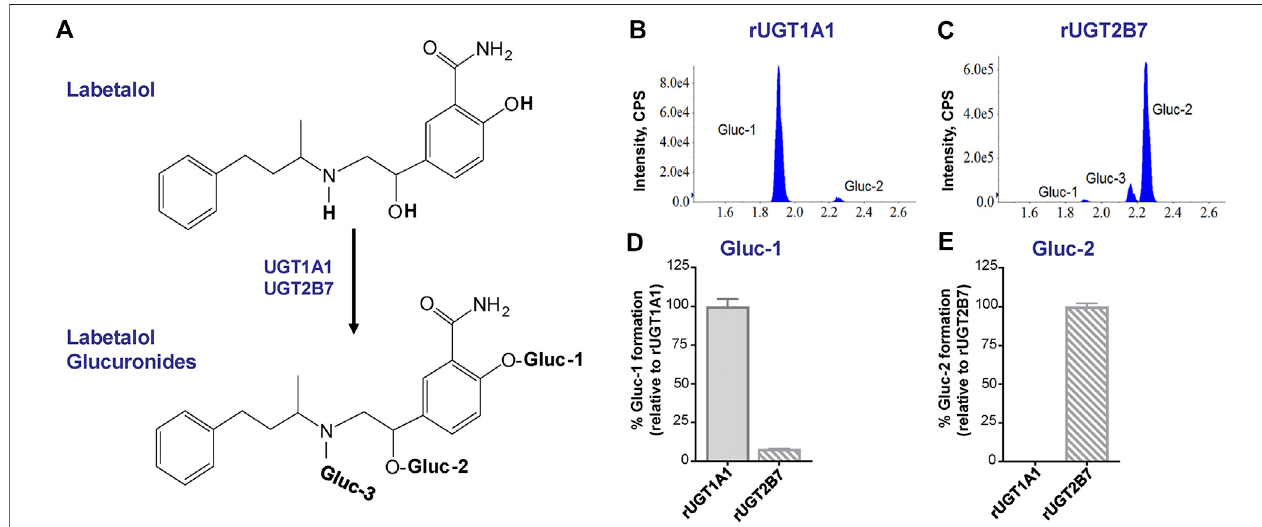
FIGURE3| UGT1A1andUGT2B7-mediatedglucuronidationoflabetalol. (A) Overview oflabetalolglucuronidationtoits phenolic-OH (Gluc-1), benzylic-OH(Gluc- 2), and N-glucuronide (Gluc-3) metabolites. Representative chromatograms of labetalol glucuronide (Gluc-1, Gluc-2, and Gluc-3) formation by human recombinant (B) UGT1A1and (C) UGT2B7.Relativeformationof (D) Gluc-1and (E) Gluc-2byhumanrecombinantUGT1A1andUGT2B7.DataareexpressedasapercentageofGluc-1 formed by UGT1A1 and Gluc-2 formed by UGT2B7, respectively ( n (cid:2) 3/group; mean ± SEM).